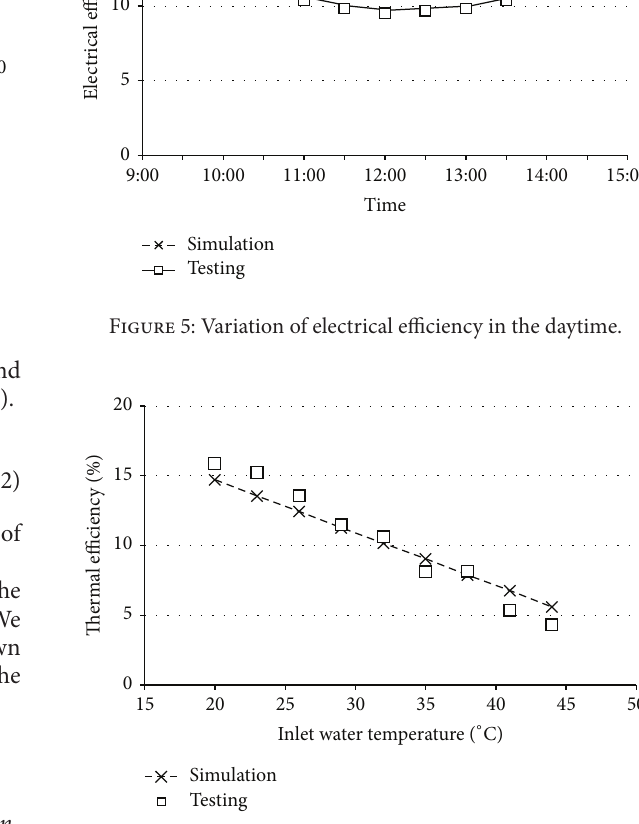
Figure 6: Variation of thermal efficiency with inlet water tempera-